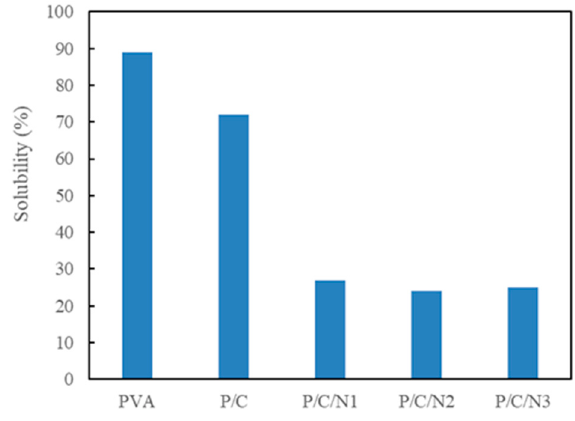
Figure 7. Solubility of the obtained composite films.